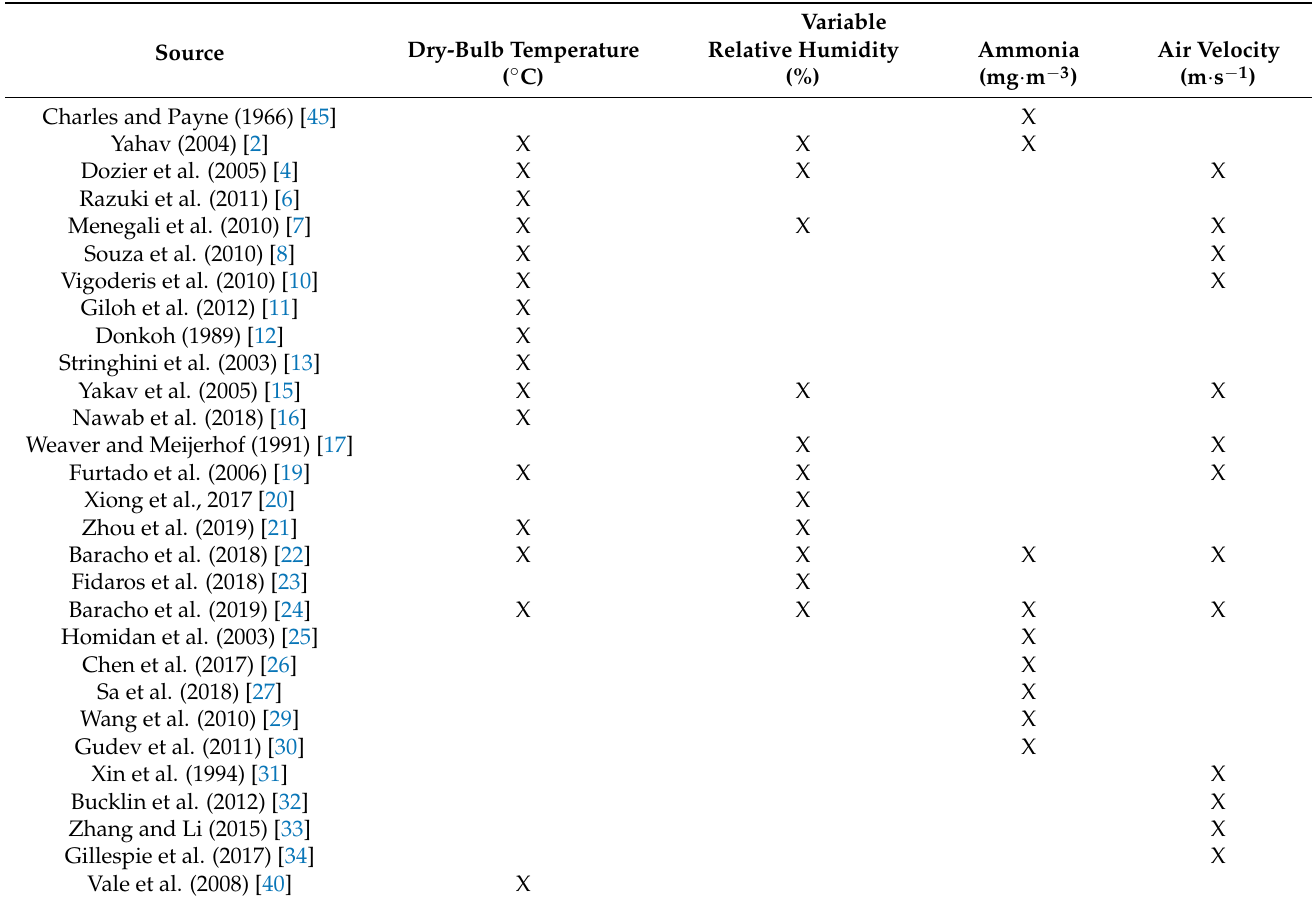
Table 1. Description of the literature reviewed that provided a basis for the environment variables’ thresholds used to build up the